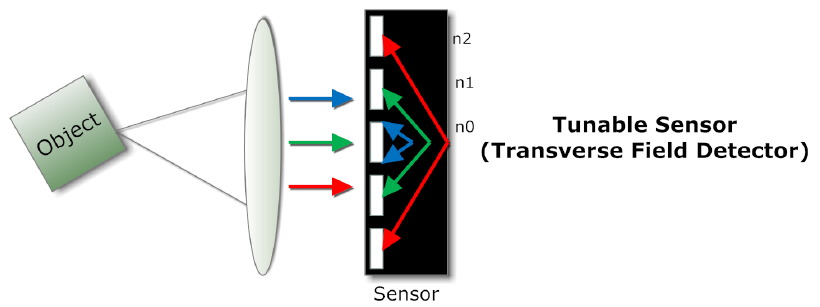
Figure 6. The multispectral reconstruction capability is based on suitable biasing. Carriers are collected by the contact pairs from different depths, and each contact pair has its own spectral